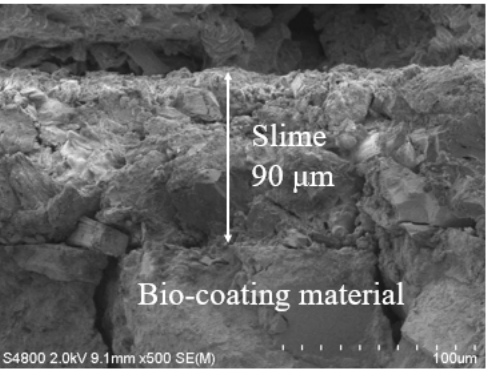
Figure 10. Typical SEM image of slime formed on the surface of bio-coating material (NPM).